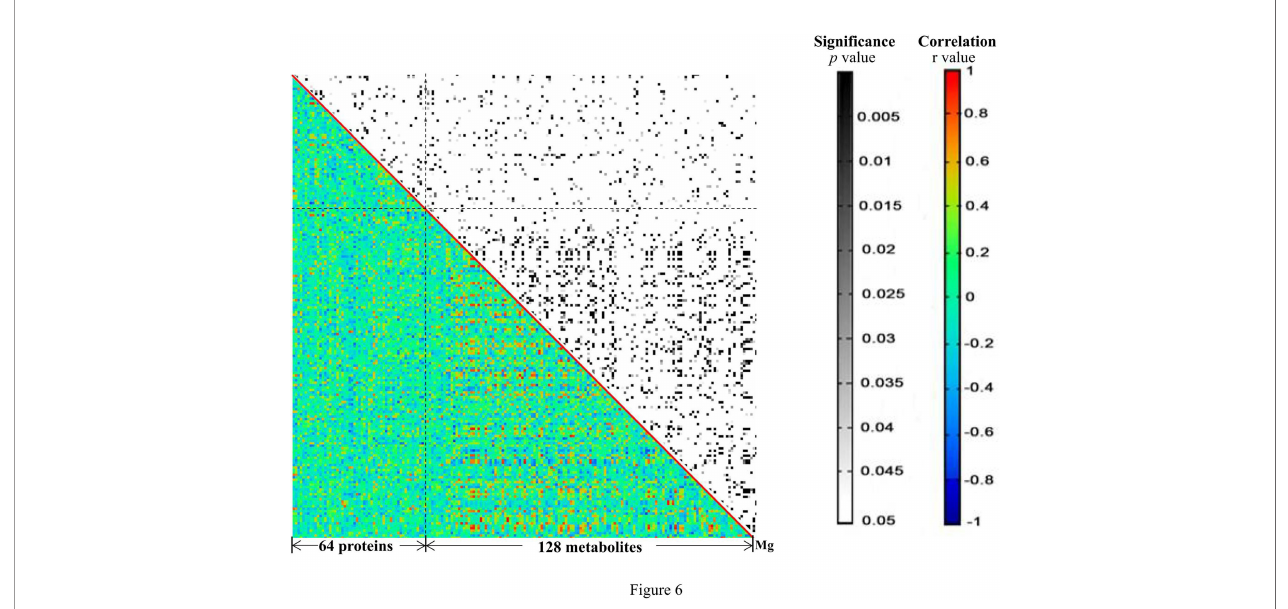
FIGURE 6 | The heat map generated from the results of correlation analysis. The p and r values of the correlations are shown in distinct colors. X- and Y-axes were divided into